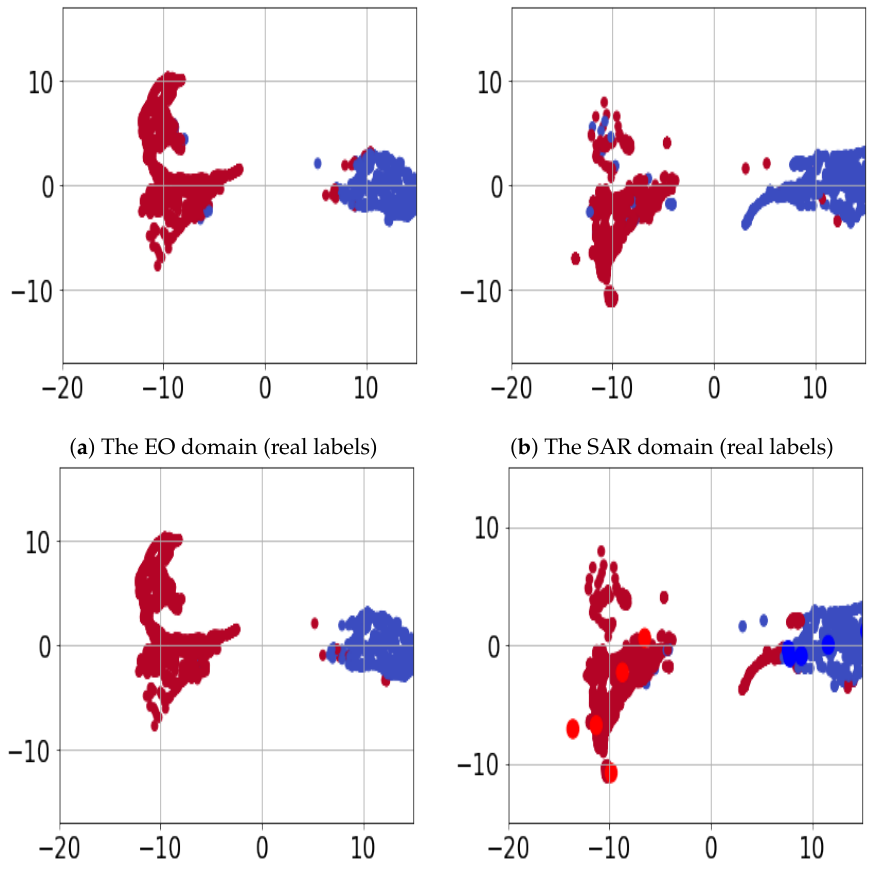
Figure 4. Umapvisualization of the EO versus the SAR dataset in the shared embedding space (view in